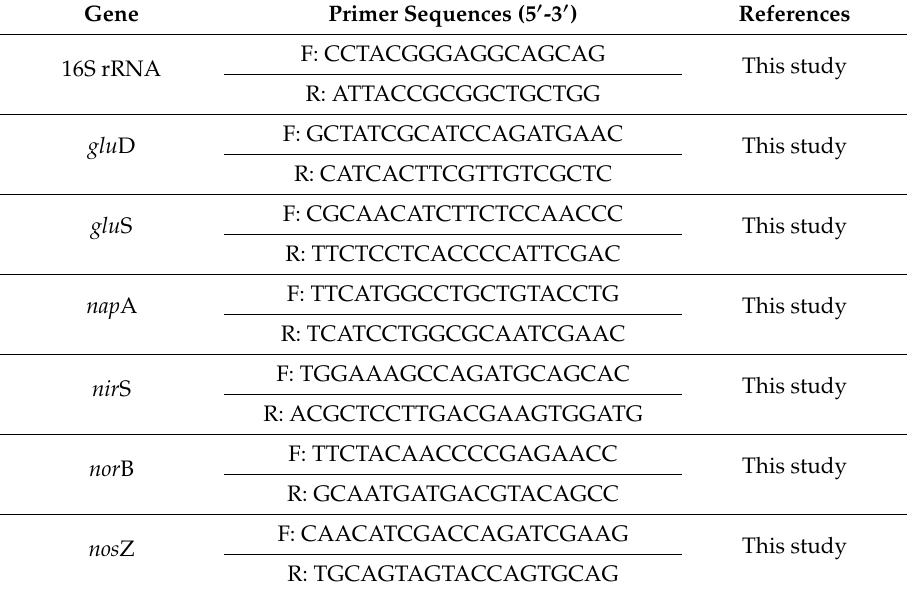
Table 1. All the primers used in this study for Pseudomonas balearica strain RAD-17. Gene Primer Sequences (5 (cid:48) -3 (cid:48)